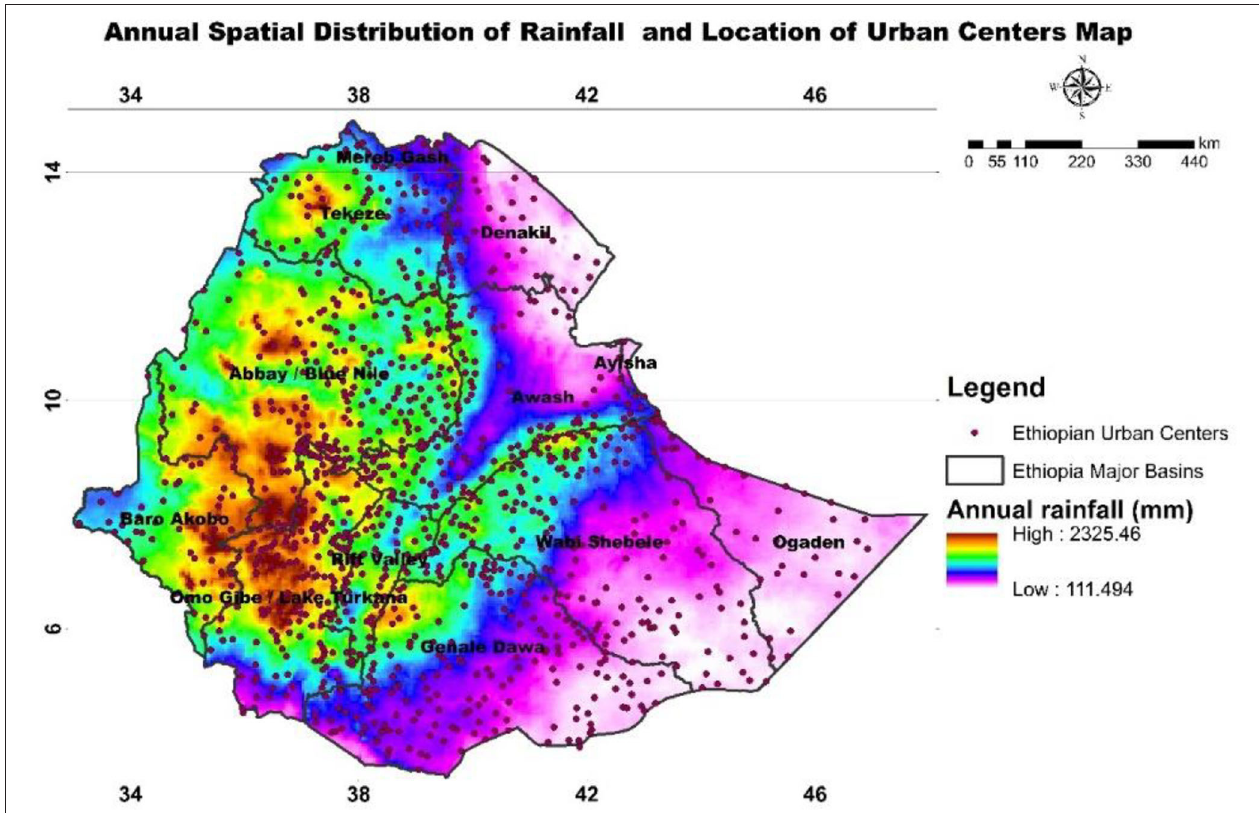
FIGURE 6 | Spatial variability of the mean annual rainfall in Ethiopia and location of urban centers. Source: the FAO